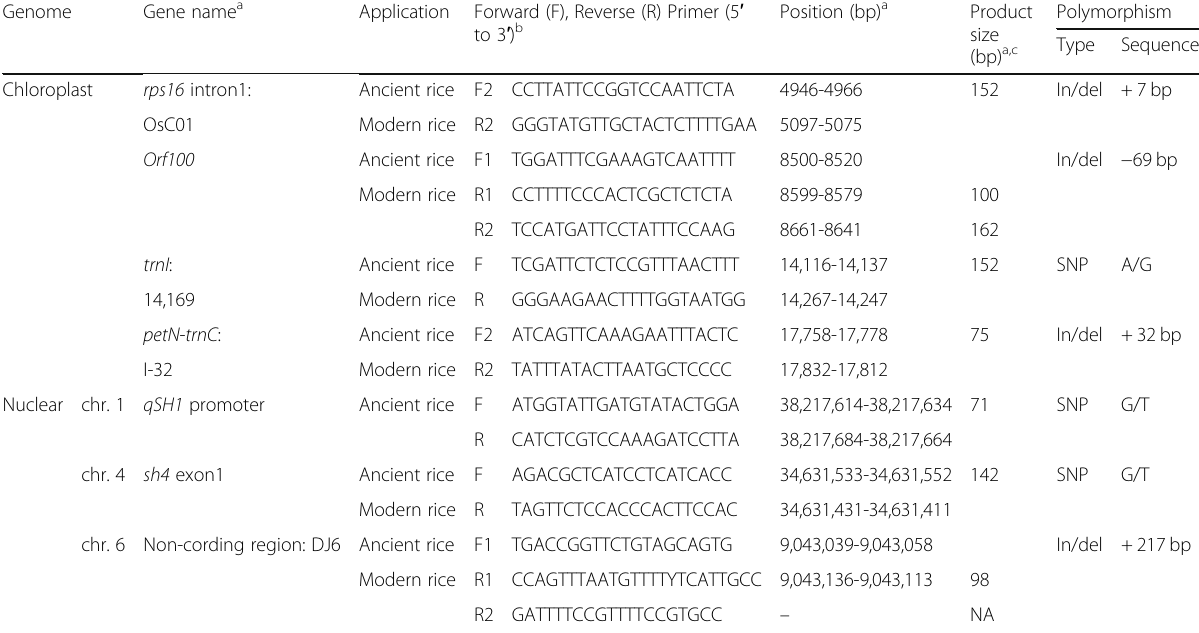
Table 2 Primer information used in this study and sequence polymorphism detected by using their primers